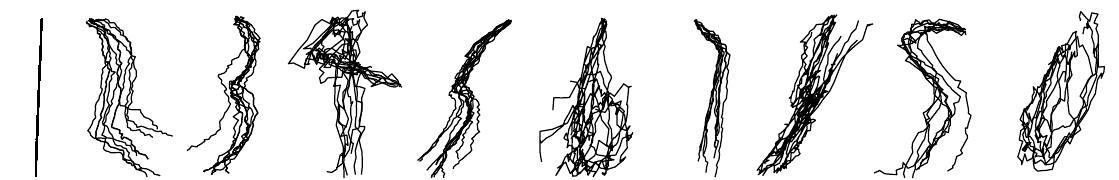
Figure 16. The randomly selected reconstructed numeric character of between-group reconstruction by the GEP.